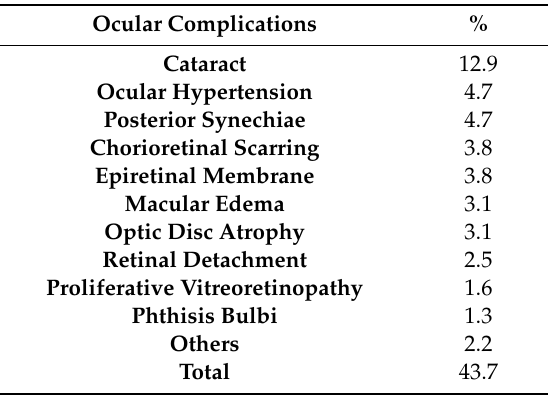
Table 2. Syphilis ocular complications (318